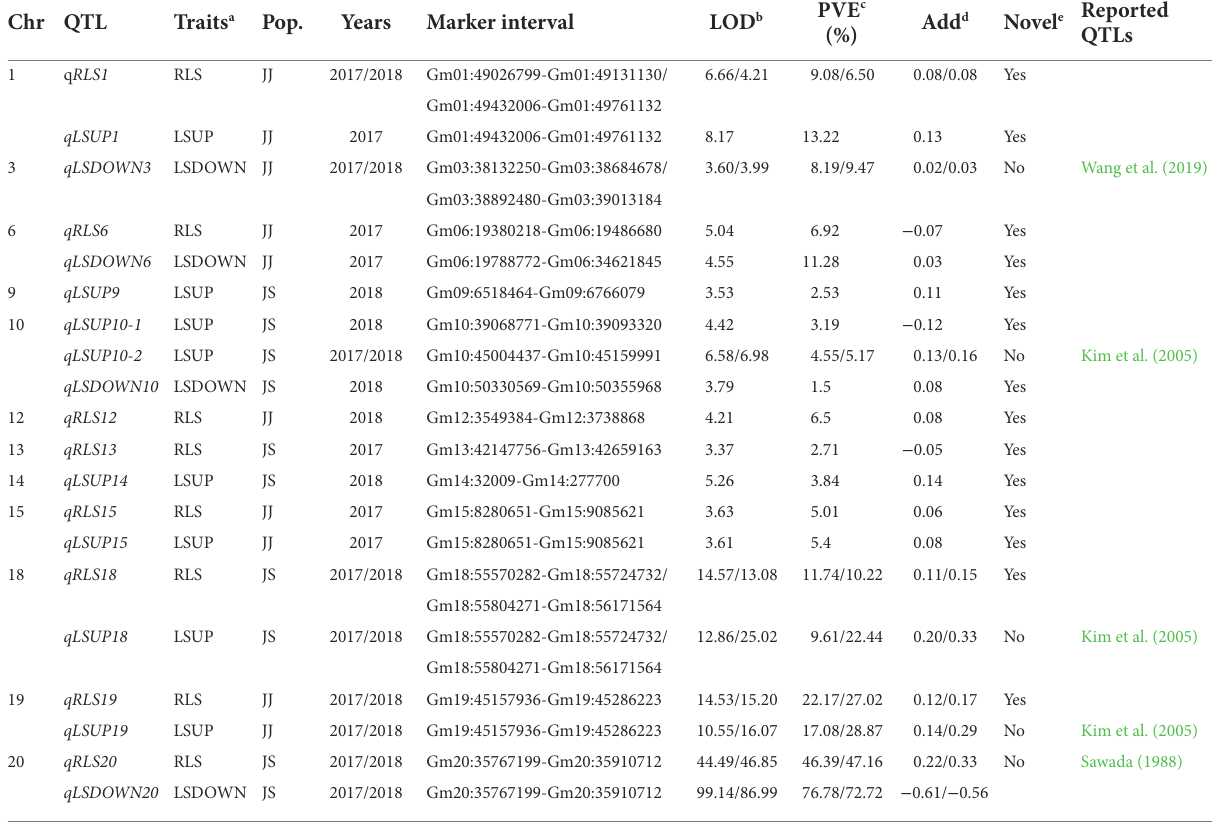
TABLE 2 QTL identified for three leaf shape related traits under two-environments based on bin markers genetic map. Chr QTL Traits